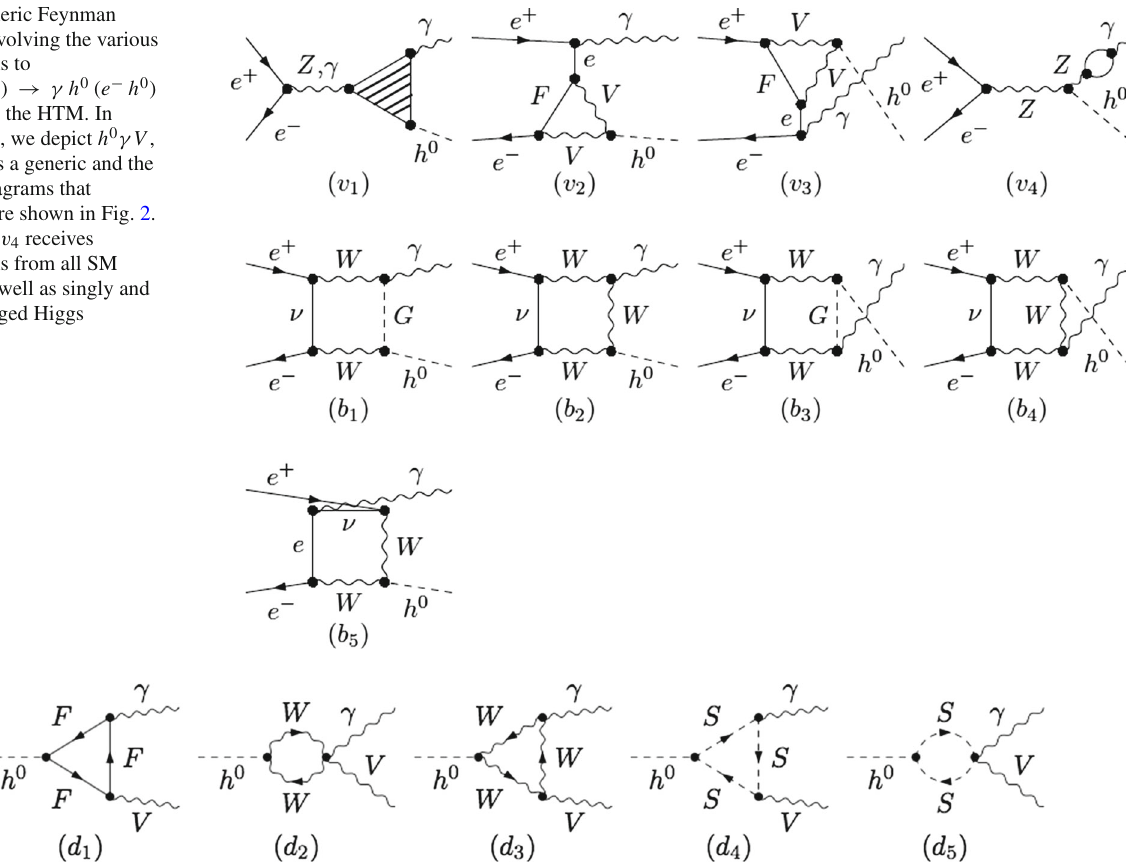
Fig. 1 Generic Feynman